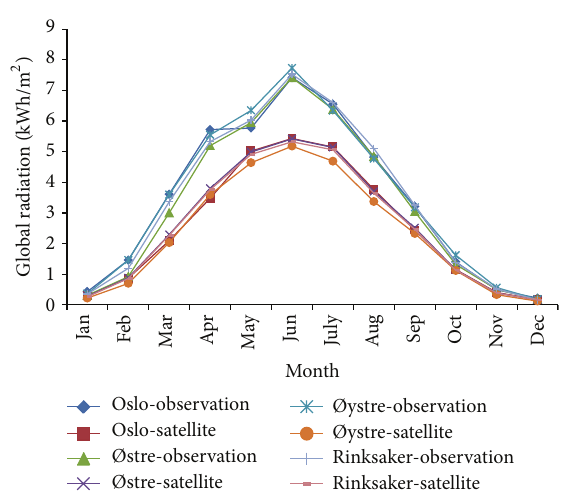
Figure 2: Monthly average observation and satellite-derived daily global solar radiation (kWh/m 2